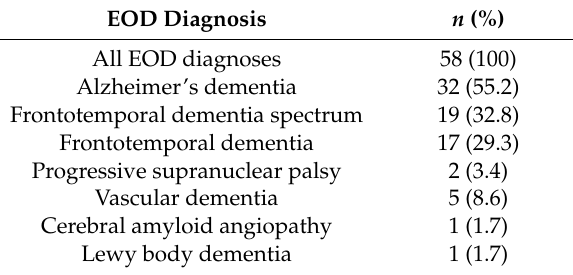
Table 1. Clinical diagnosis of early-onset dementia